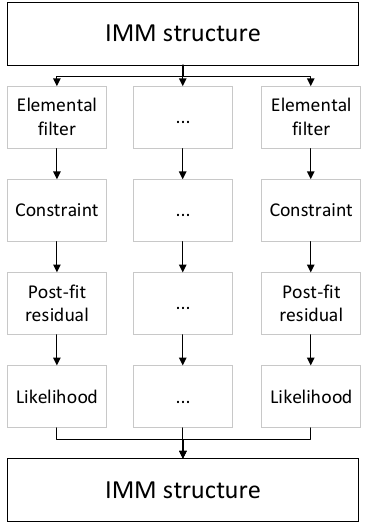
Figure 2. Dataflow of the proposed method.